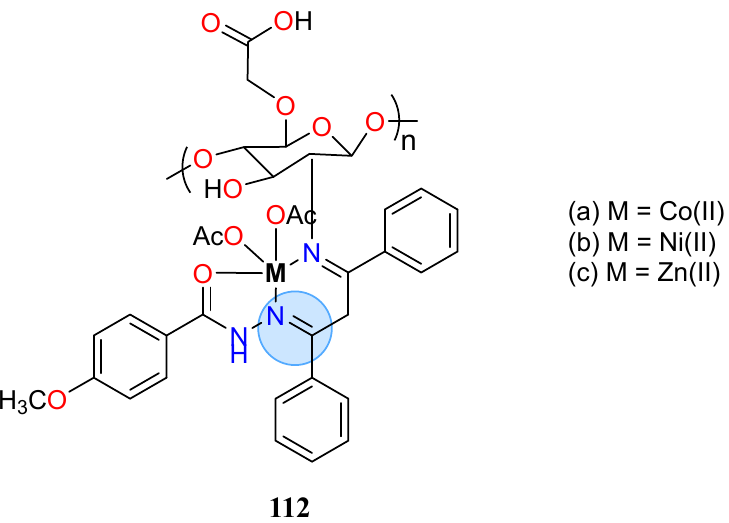
Figure 58. Co(II), Ni(II) and Zn(II) complexes with a tridentate Schiff base ligand (NNO) derived from hydrazide functionalized with a biopolymer.